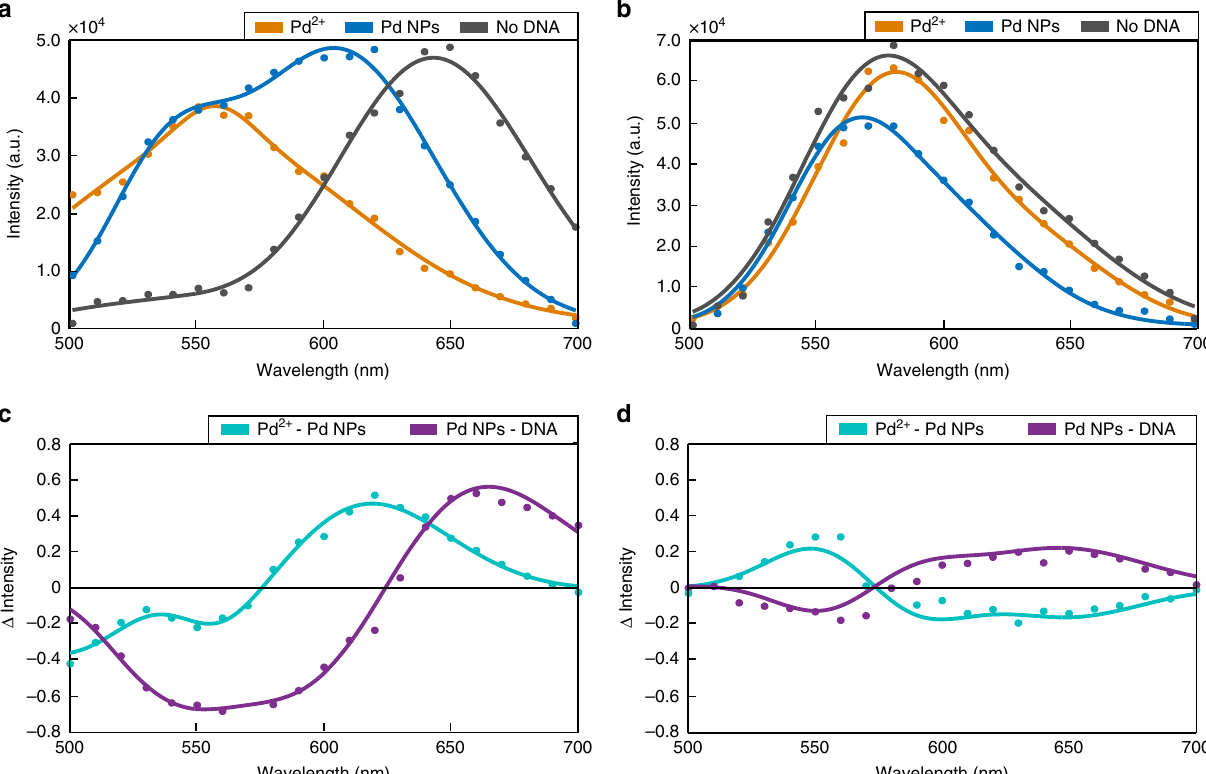
Fig. 5 Effect of DNA removal on PR spectra. a Exemplary hyperspectral spectra collected from the same PR before reduction of Pd 2 + (orange), after reduction of Pd 2 + to Pd NPs (blue), and after DNA removal (gray). b Same data as in ( a ) but for a PR that shows a blue-shift upon Pd NP formation. c Difference spectra calculated from the normalized PR spectra for i.) Pd 2 + reduction to Pd NPs (blue) and ii) the removal of the DNA (purple) from ( a ). d Difference spectra calculated from the normalized PR spectra from ( b